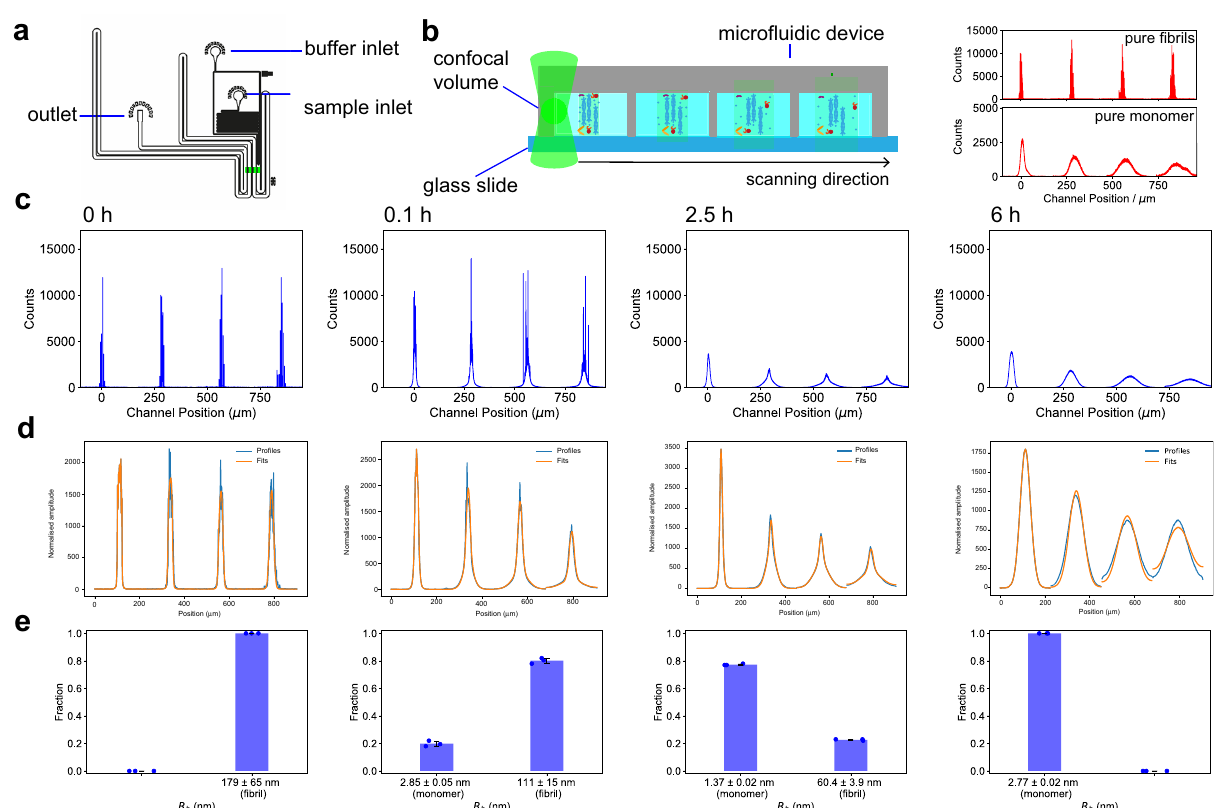
Fig. 3 Analysis of α S fi bril disaggregation by the Hsc70 chaperone machinery using confocal micro fl uidic diffusional sizing. a Design of the micro fl uidic device for confocal micro fl uidic diffusional sizing. The chip design is the same as for the epi fl uorescence microscopy experiments (see Fig. 1). b The confocal volume scans across the four innermost channels of the micro fl uidic chip made of polydimethylsiloxane (PDMS) (highlighted in panel a ), thereby capturing the diffusive broadening of the reaction mixture with increased diffusion time. (Right) Typical diffusion pro fi les for pure fi brils and monomers. Pure fi brils show large fl uorescence bursts due to the high number of fl uorophores detected per fi bril, as well as little broadening due to the large size of the fi brils. Pro fi les for pure monomer samples exhibit no bursts, due to the bulk concentrations employed and because each detected monomer only carries one label. Monomer pro fi les are broadened signi fi cantly in comparison to fi brils due to the small hydrodynamic radius of the monomeric protein. c Diffusion pro fi les for confocal scanning across the micro fl uidic channel for α S fi brils at different time points during the disaggregation reaction. Consistent with Fig. 2, the width of the pro fi le base broadens signi fi cantly. Furthermore, the bursts, indicating the presence of numerous fl uorophores as found in a fi brillar state, vanish at later time points, consistent with the disappearance of fi brils as a result of Hsc70-mediated disaggregation. d Fitting generated for pro fi les in panel ( c ). Normalised experimentally obtained diffusional pro fi les are shown in blue and the obtained fi ts in orange. e Histograms showing the size and fractional distribution of the two species from diffusion pro fi le analysis. At 0 and 360 min, R h values of single-component fi ts are reported. The individual data points are overlaid on the bar plot. Data in e are represented as mean ± standard deviation of n = 3 independent